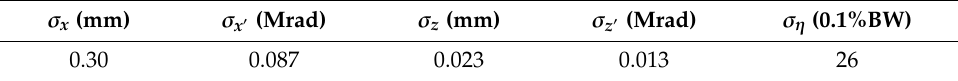
Table 1. Source parameters of a Cornell Compact